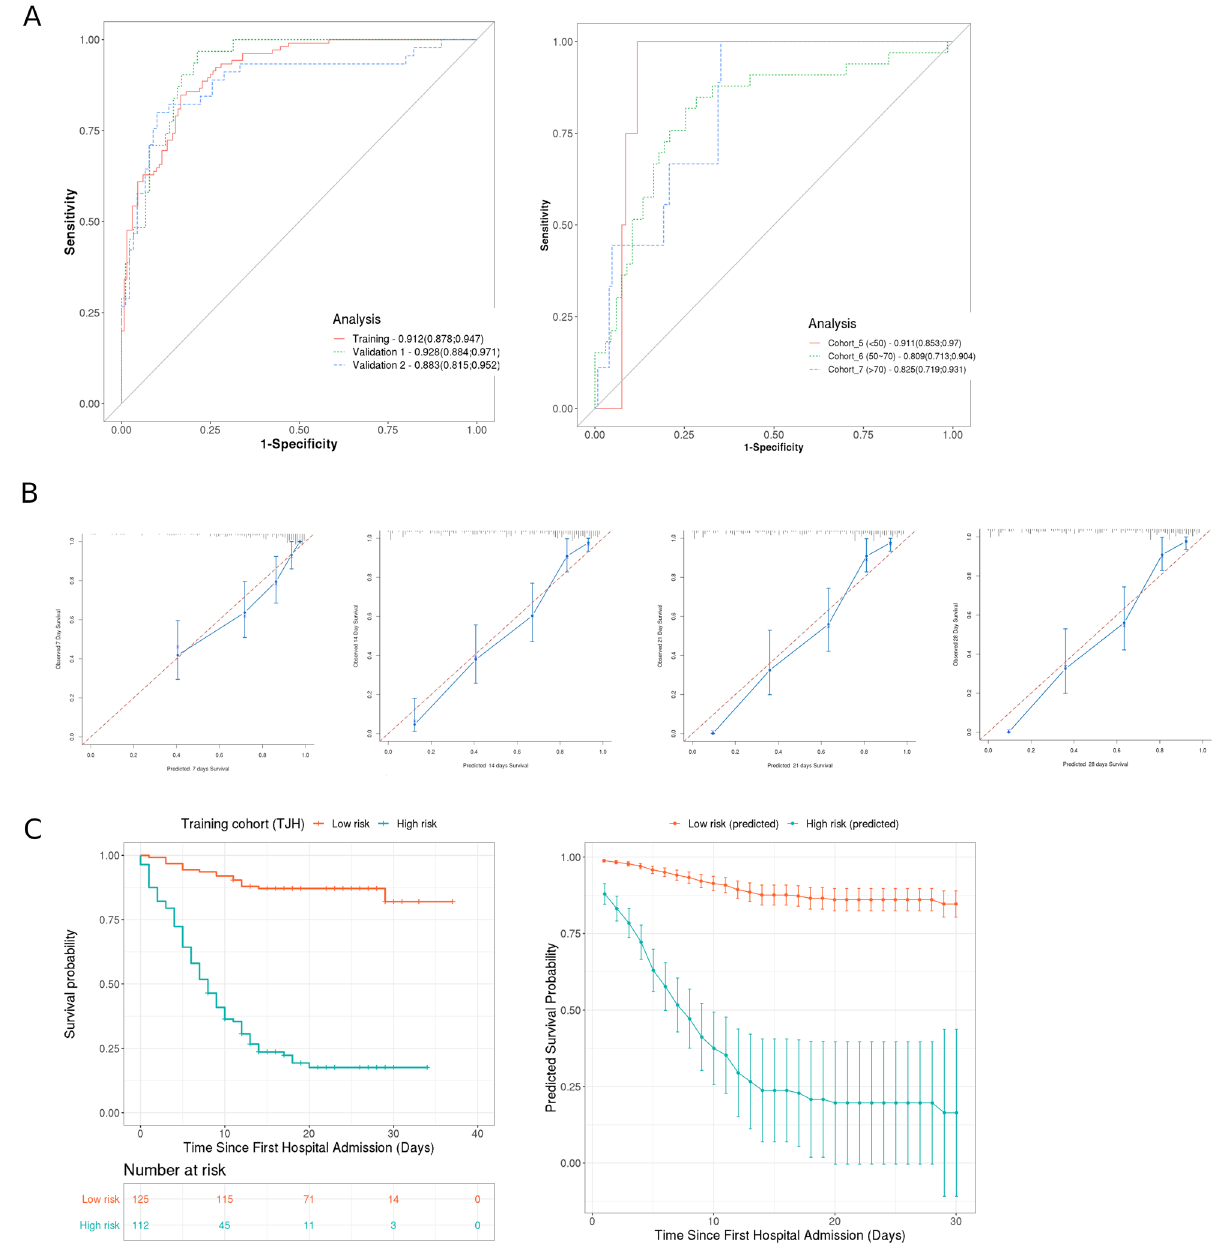
Figure 1. ( A ) AUC (area under curve) of the ROC (receiver operating characteristic) analysis for the training cohort and two validation cohorts (left), and for the age-specific three cohorts (< 50 year, 50–70 year, and > 70 year, right). ( B ) Calibration plot showed the comparison between predicted and observed survival rates of patients in training cohort on 7th, 14th, 21th, and 28th after hospital admission. ( C ) Clinical stratification and prediction of survival rate on the basis of the developed prognostic model. Survival in the low and high risk subgroups in training cohort (TJH) were stratificated by the a cutoff of ≤ 799 and > 799, respectively (left), predicted survival rates in the this cohort (right). Smooth lines represent mean predicted survival probabilities for each risk group; dots symbolize corresponding predicted rates with 95% CI (vertical lines) (this figure is produced using R version 3.6 37